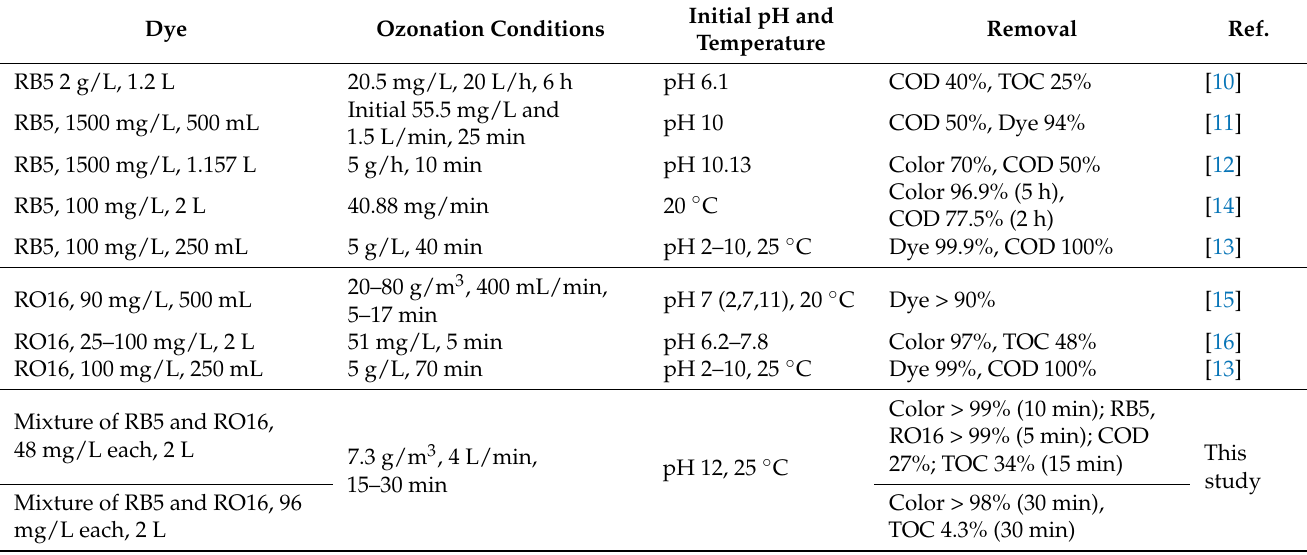
Table 1. Studies of ozonation of RB5 and